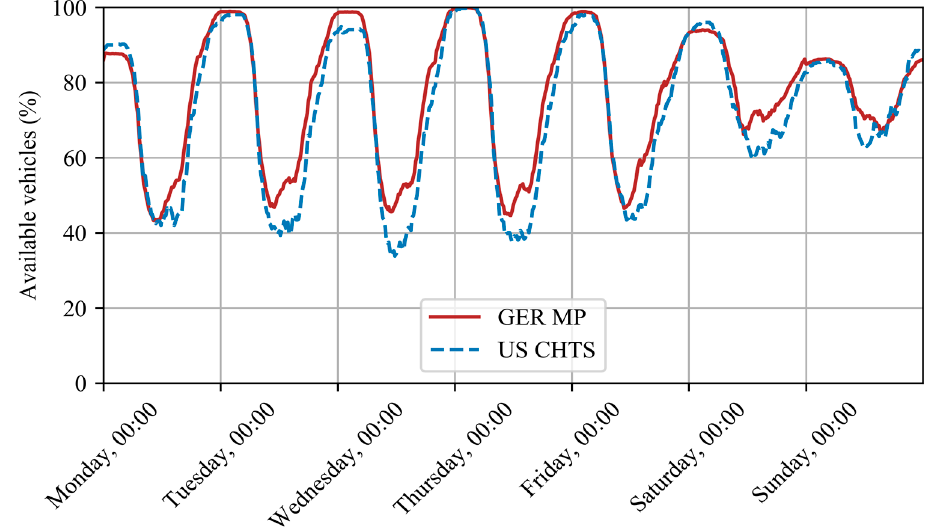
Figure 3. Percentage of vehicles available at home during an average week. The maximum number of vehicles available at home is 6 for the US CHTS data and 120 for the GER MP.